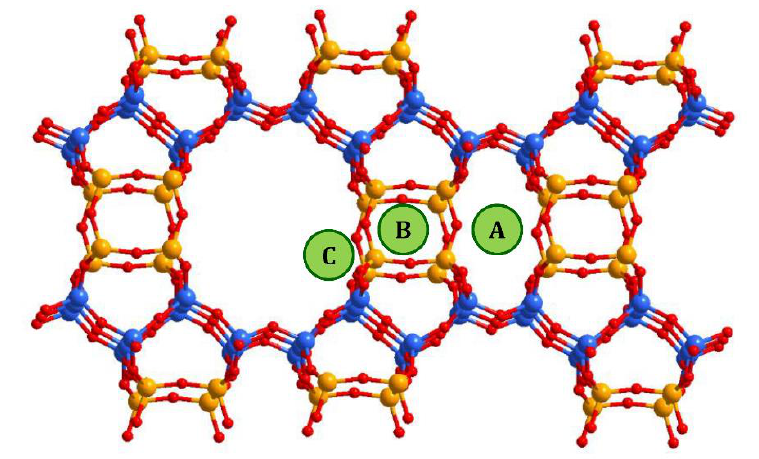
Figure 5. Possible cationic sites in the mordenite framework. Blue balls correspond to Si atoms in T1 and T2 sites of the mordenite lattice, orange balls are those Si atoms that can be substituted by Al (T3 and T4 sites).